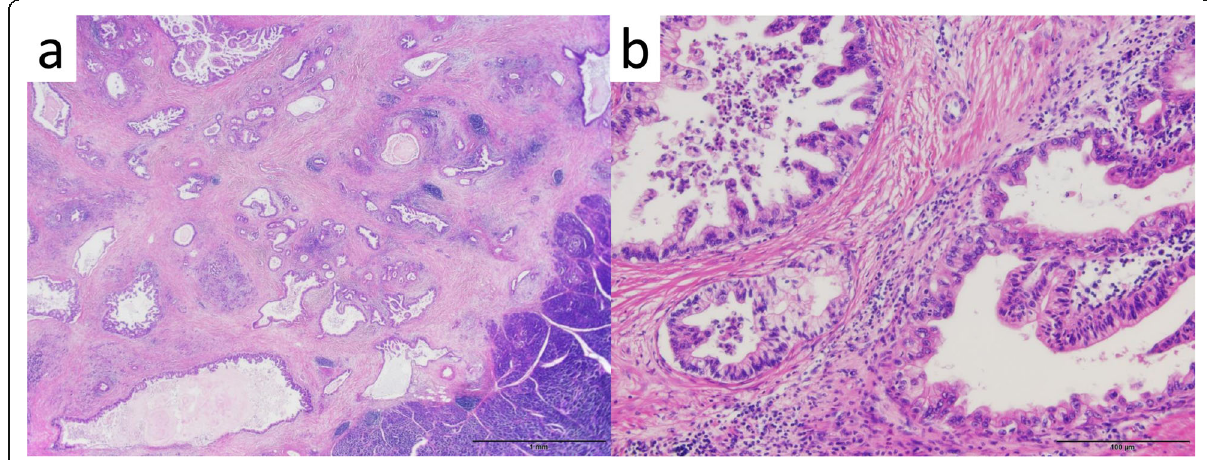
Fig. 3 Histopathological findings (hematoxylin – eosin staining) showing well-differentiated invasive ductal adenocarcinoma with lymphatic invasion. a × 4 and b × 40 original